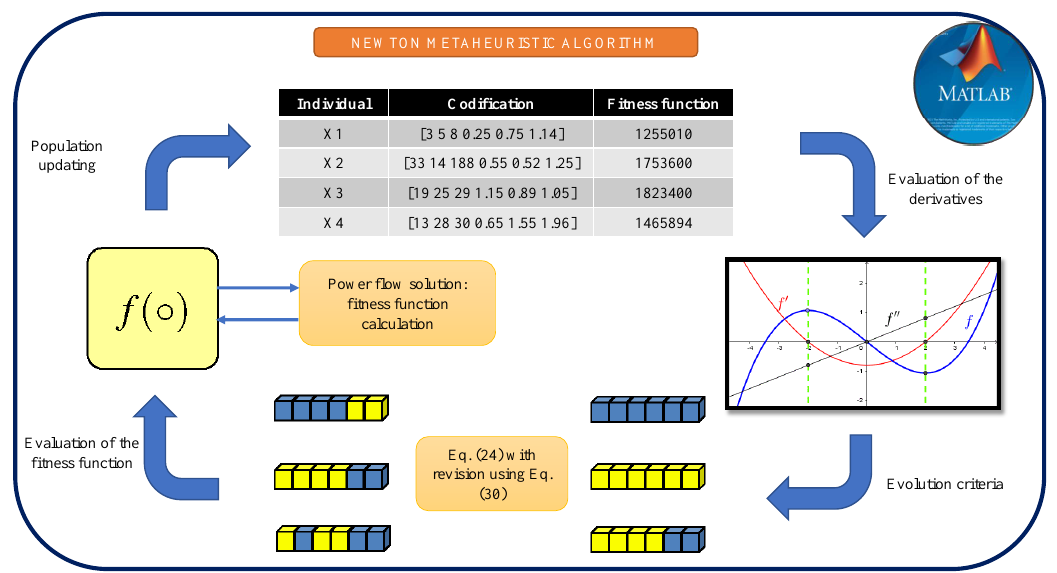
Figure 5. Implementation of the proposed methodology in the MATLAB programming